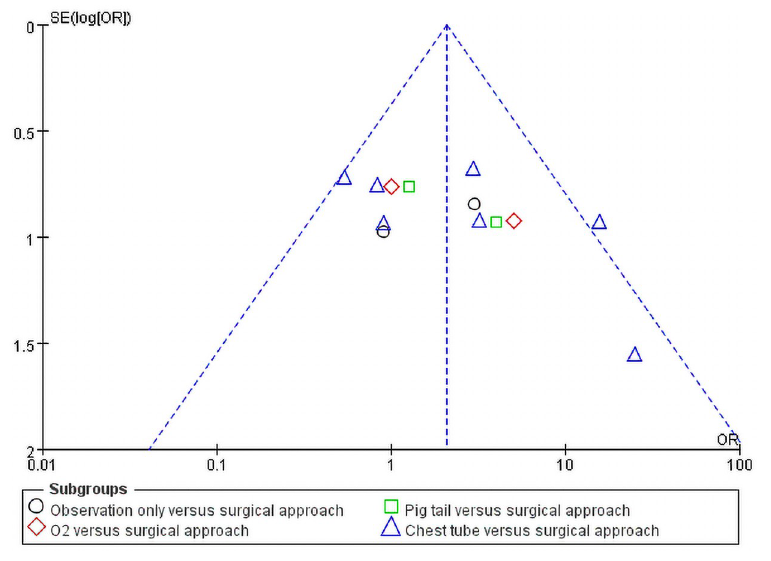
Fig 5. Publication